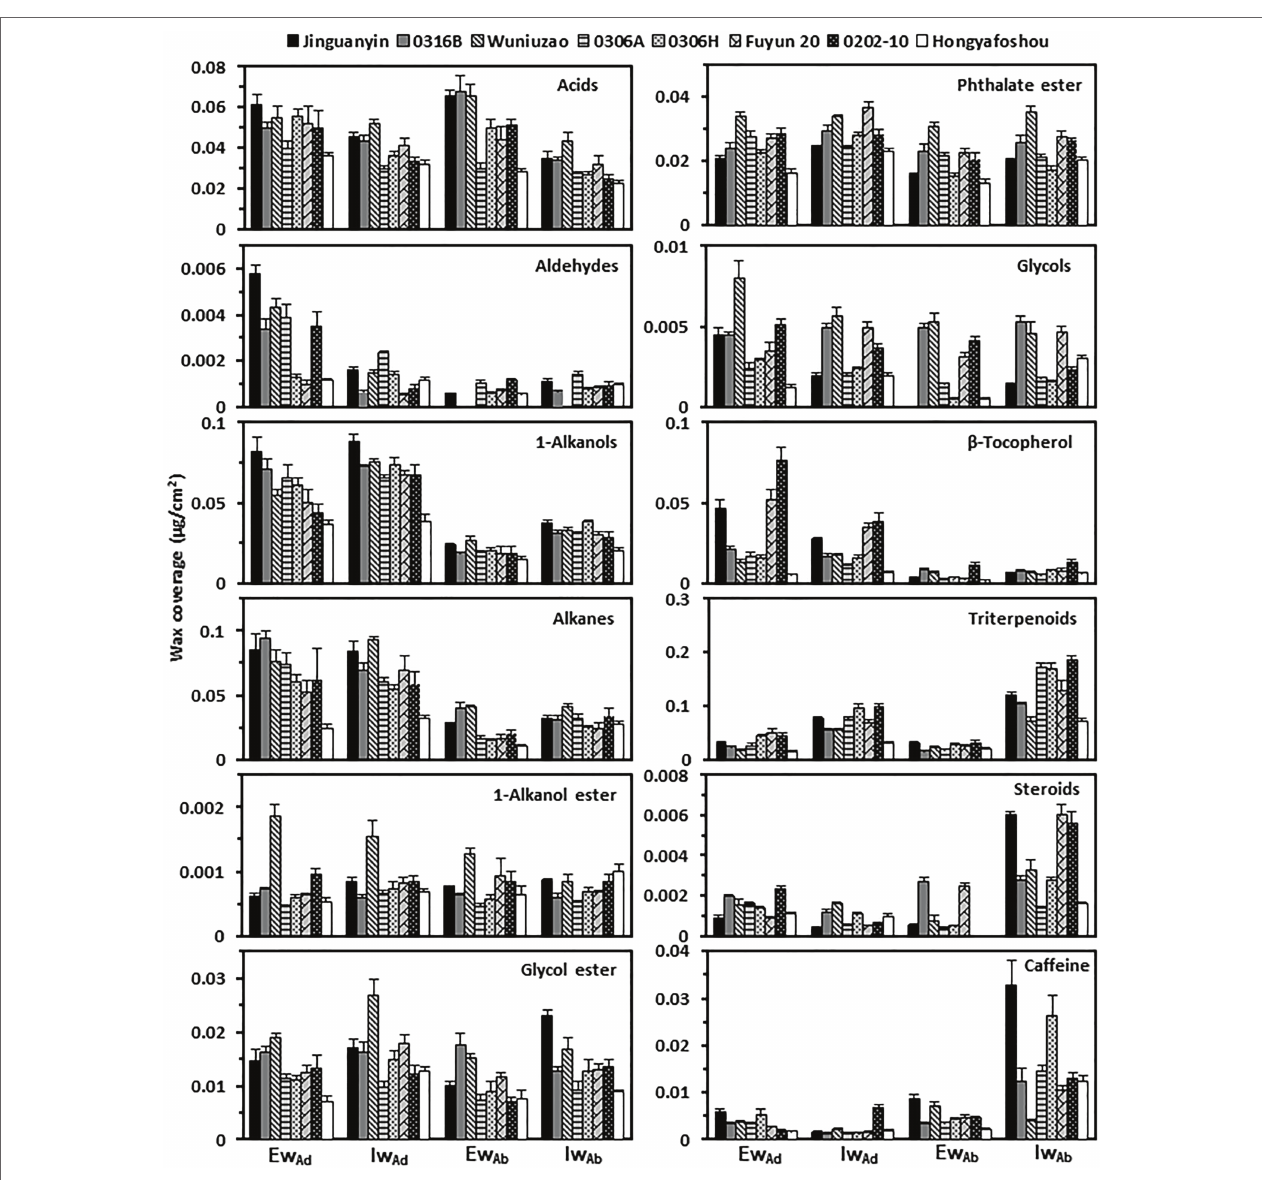
FIGURE 3 | The wax compositional comparison from the epi- and intracuticular compartments among the eight tea germplasms. Ew Ad : the adaxial eipcuticular waxes; Iw Ad : the adaxial intracuticular waxes; Ew Ab : the abaxial eipcuticular waxes; Iw Ab : the abaxial intracuticular